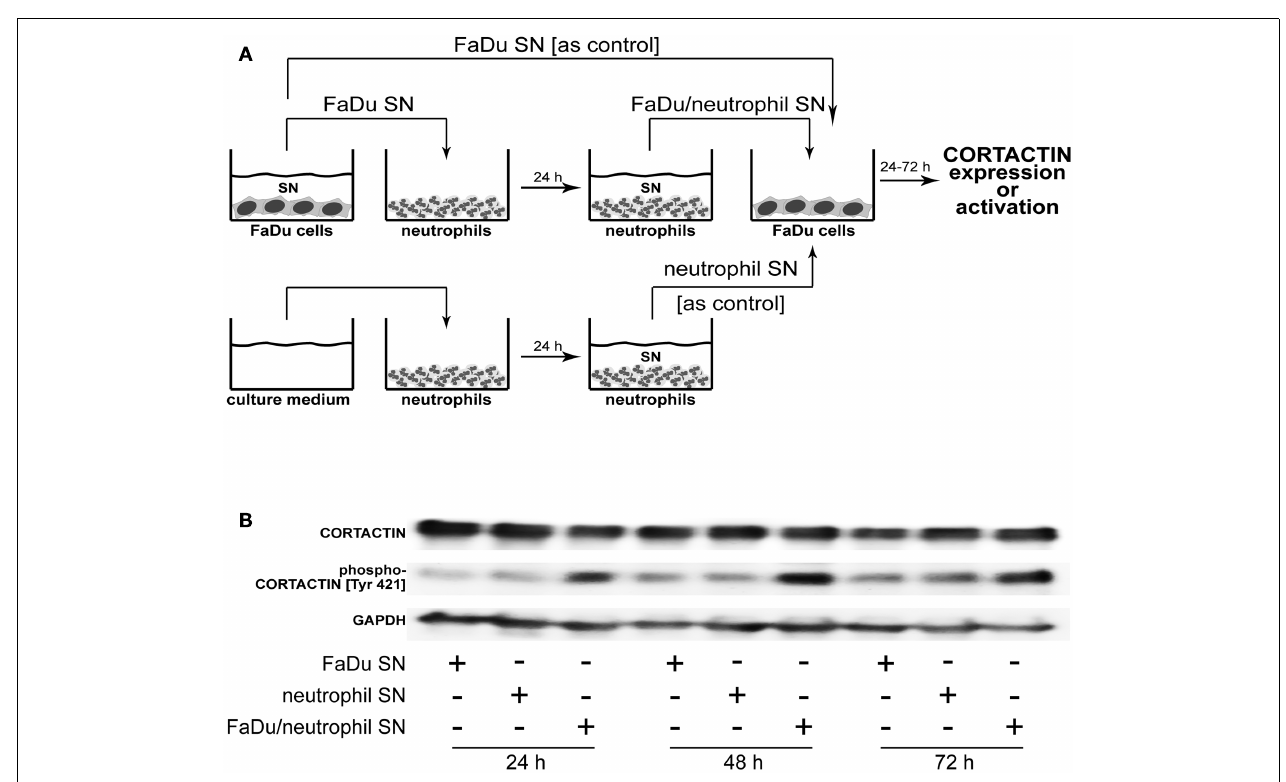
CORTACTIN expression and activation were assessed by western blot using antibodies against total CORTACTIN (upper panel) or phosphorylated CORTACTIN (Tyr 421; middle panel). GAPDH (lower panel) was used as control for the quantity and quality of protein lysates.The results are representative for five independent experiments